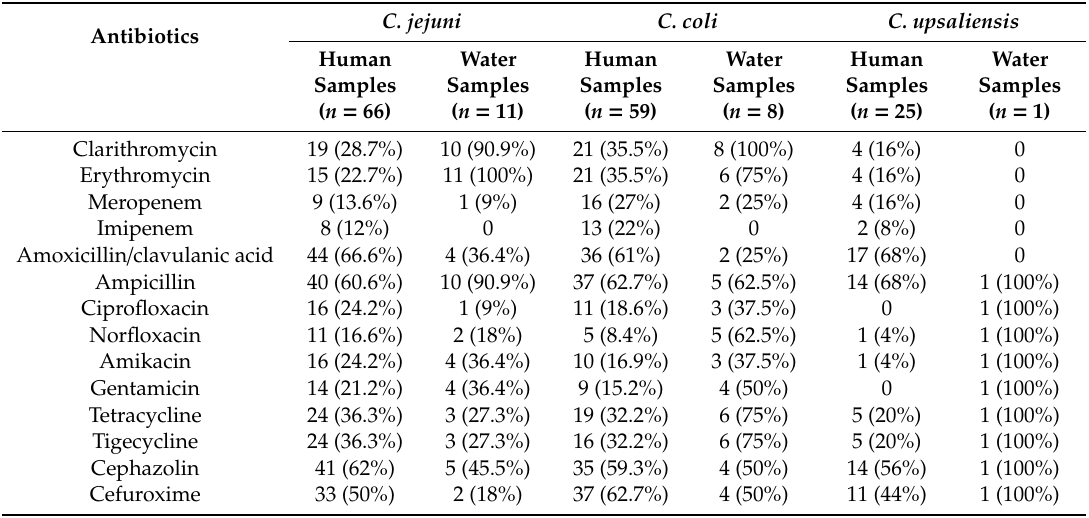
Table 4. Antimicrobial resistance rates of C. jejuni, C. coli and C. upsaliensis from clinical specimens.